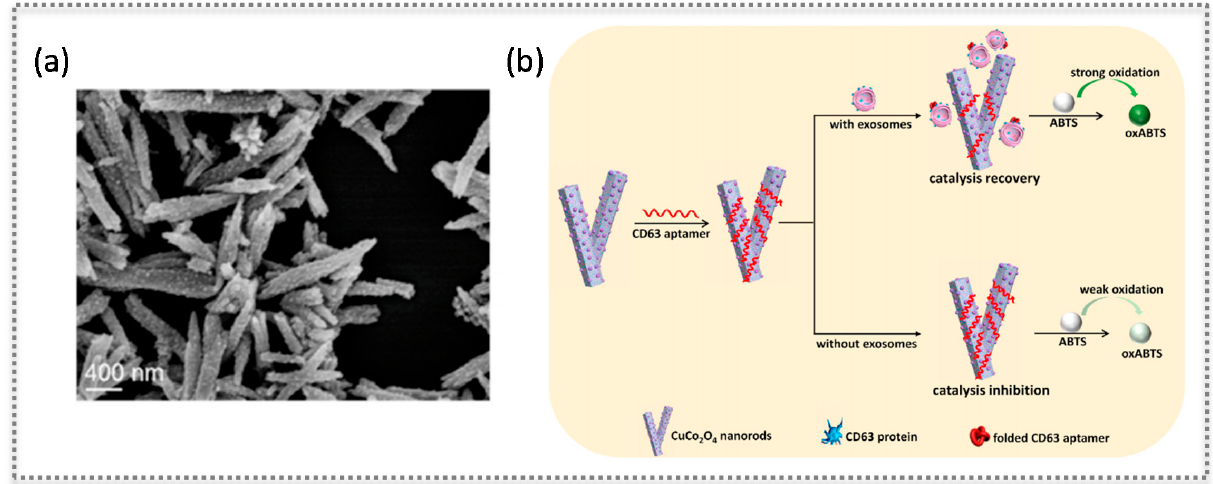
Figure 6. Nanozyme based on CuCo 2 O 4 nanorods: SEM characterization ( a ) and scheme showing the modulation of oxidase-like activity of the nanorods by the adsorption of the aptamer that recognizes CD63 protein on exosomes ( b ), as a label-free sensing approach. (Reproduced with permission [31], Copyright 2020, Elsevier B.V.).